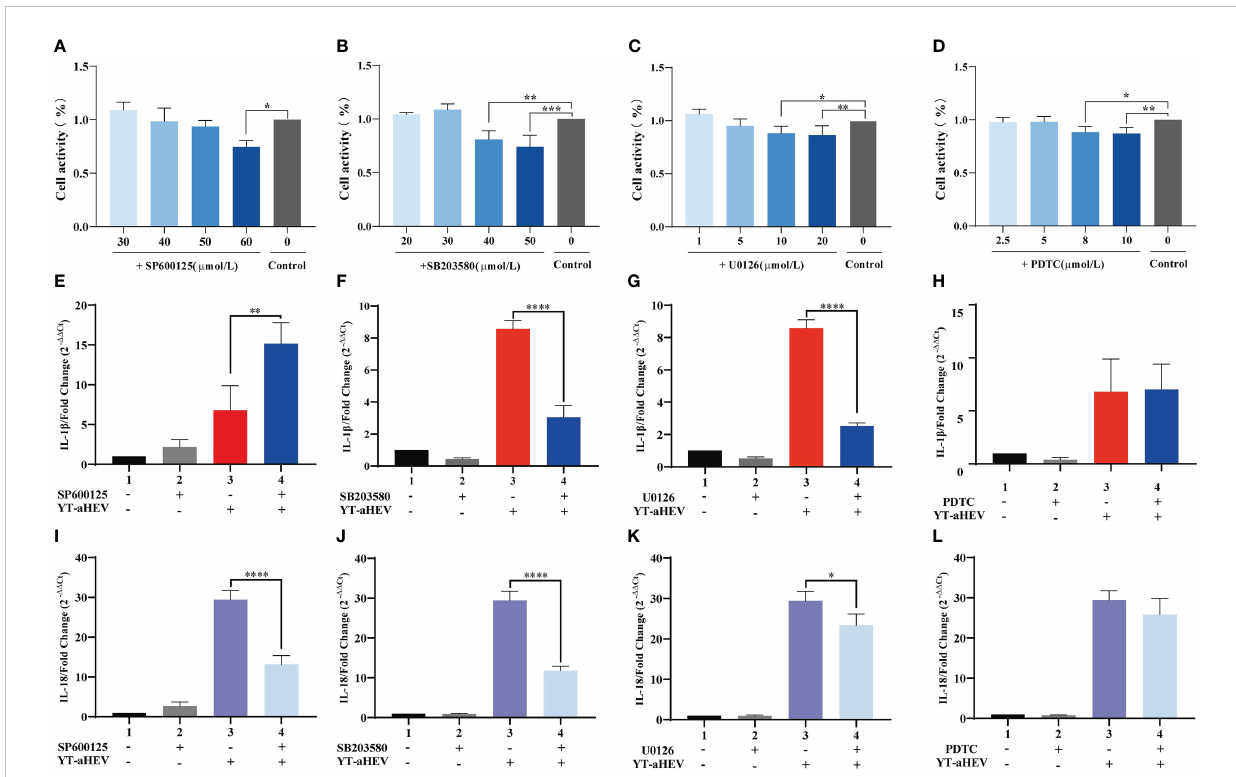
FIGURE 5 The effects of MAPK and NF- k B signaling pathway on YT strain – induced in fl ammatory response in LMH cell. (A – D) CCK8 detects the effects of different inhibitor concentration on LMH cells. (E – H) Effect of MAPK inhibitors (U0126, SB 203580, and SP600125) and NF- k B (PDTC) on IL-1 b . (I – L) Effect of MAPK inhibitors (U0126, SB 203580, and SP600125) and NF- k B (PDTC) on IL-18. Symbols indicate inhibitor-treated and untreated cells; *P < 0.05, **P < 0.01, ***P < 0.001 and ****P <